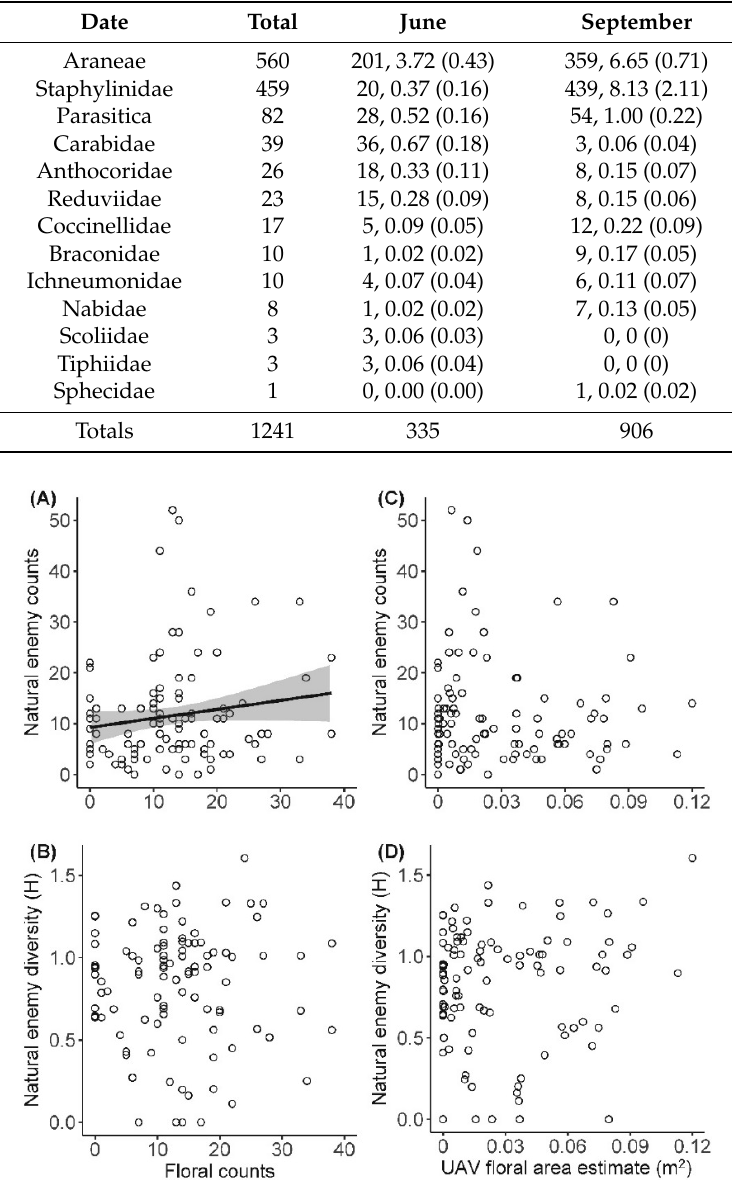
Table 3. Summary of natural enemies observed in wildflower plots collected by suction sampling. Arthropod taxa are organized by seasonal total rank abundance. For each sampling date, values represent: total, mean (±1SE). Araneae represent all true spiders, and Parasitica represents other parasitoids (i.e., not Braconidae or Ichneumonidae).